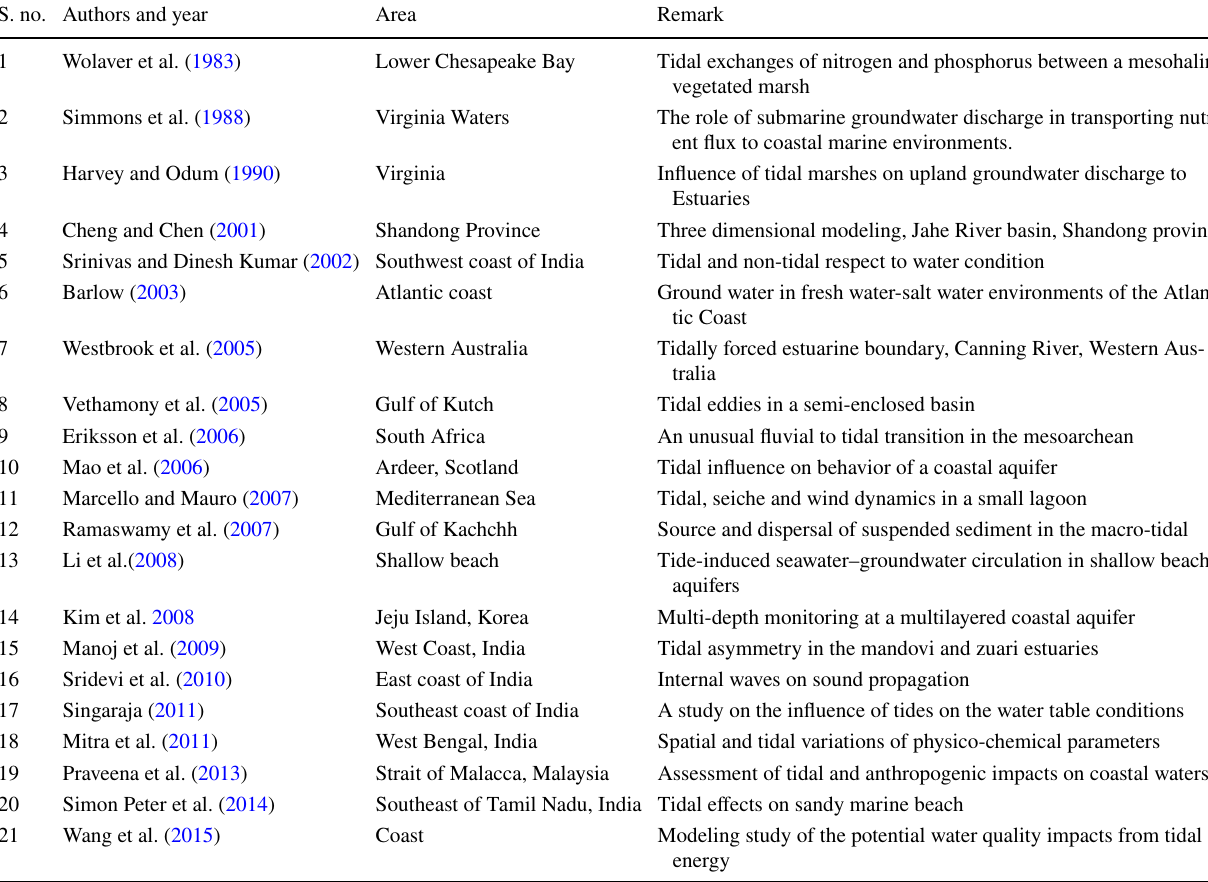
Table 1 Study on Literature of tidal in the different parts of the